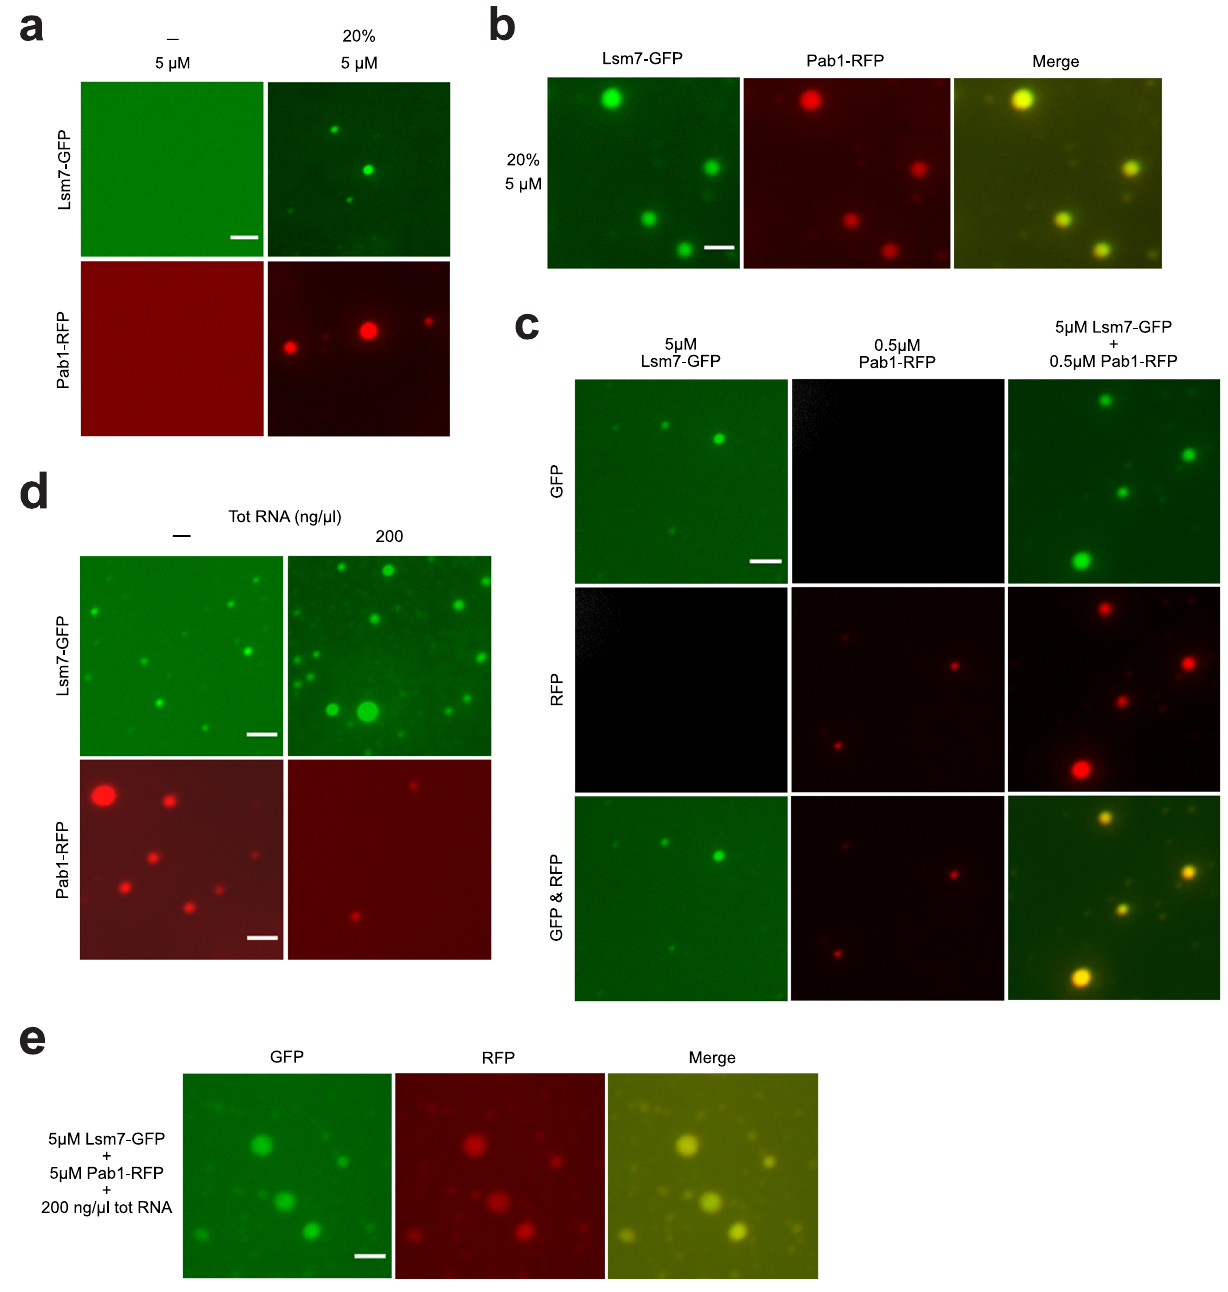
Fig. 6 Lsm7 co-phase separates with Pab1 in vitro. a Puri fi ed Lsm7-GFP and Pab1-RFP phase separate in vitro with the addition of 20% Dextran 70 (pH 7.4, NaCl 150 mM, protein concentration 5 μ M). Images show representative data from three independent experiments. Scale bar, 2 μ m. b Lsm7-GFP and Pab1-RFP co-phase separate when added together (20% Dextran 70, pH 7.4, NaCl 150 mM, protein concentration 5 μ M). Images show representative data from three independent experiments. Scale bar, 2 μ m. c The addition of 0.5 µ M Pab1 together with 5 µ M Lsm7 results in an increased droplet formation (20% Dextran 70, pH 7.4, NaCl 150 mM). Images show representative data from three independent experiments. Scale bar, 2 μ m. d Addition of total yeast RNA (200 ng/ μ l) enhances Lsm7-GFP droplet formation and decreases Pab1-RFP demixing (20% Dextran 70, pH 7.4, NaCl 150 mM, protein concentration 5 μ M). Images show representative data from three independent experiments. Scale bar, 2 μ m. e During co-phase separation of Lsm7 and Pab1 (5 μ M), in